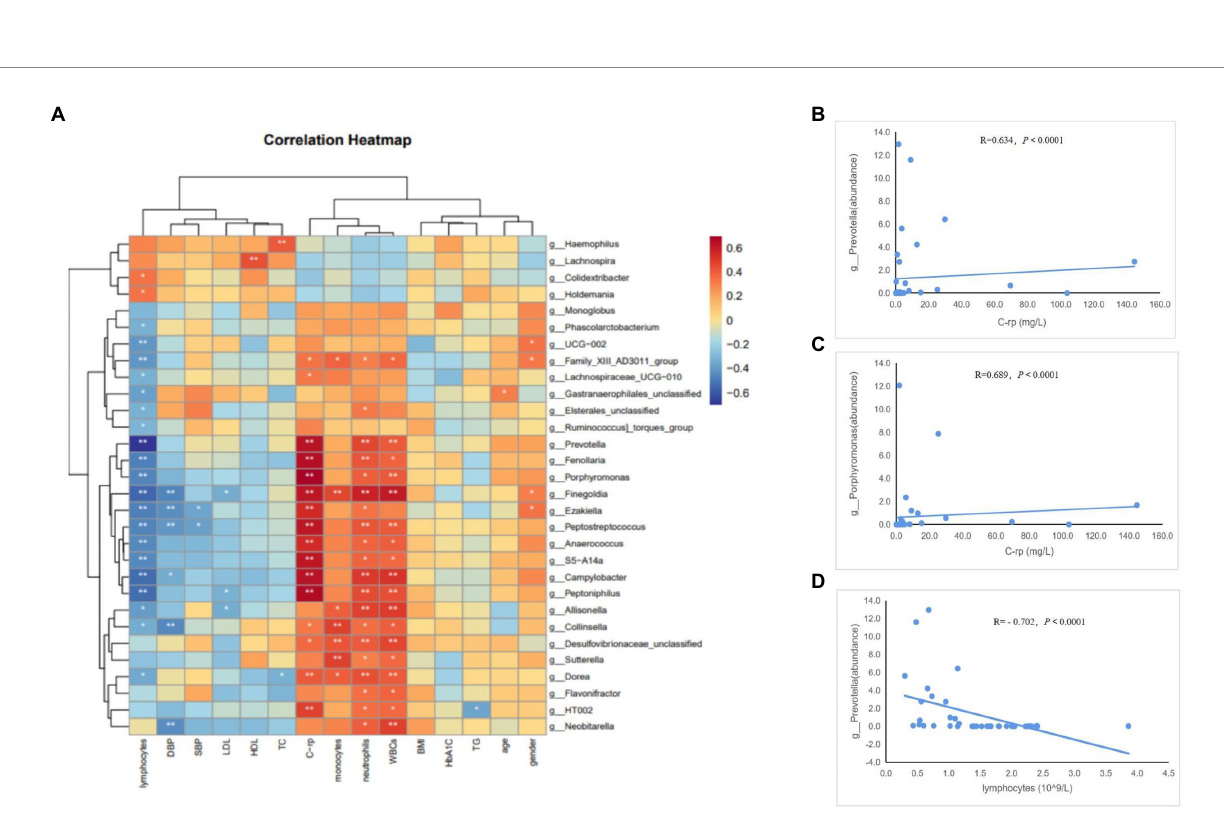
FIGURE 5 Spearman correlation analysis of different bacteria and clinical characteristics. (A) Heatmap showing the correlation between different bacteria and clinical characteristics. (B) Scatter plots showing the correlation between C-rp and Prevotella . (C) Scatter plots showing the correlation between C-rp and Porphyromonas . (D) Scatter plots showing the correlation between lymphocytes and Prevotella . The color intensity represents magnitude of correlation. Red reflects positive correlations, blue reflects negative correlations; * p < 0.05; ** p <